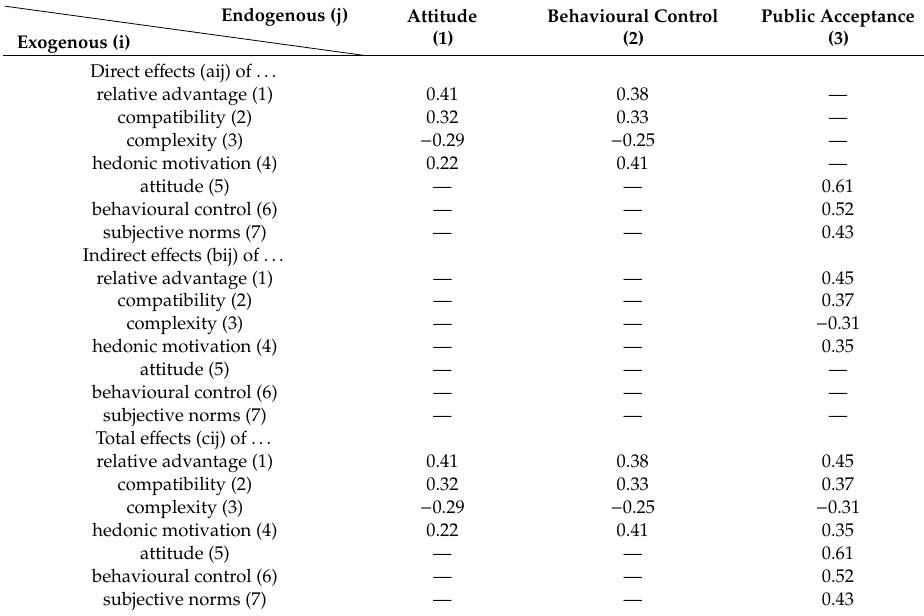
Table 5. Direct, indirect and total e ff